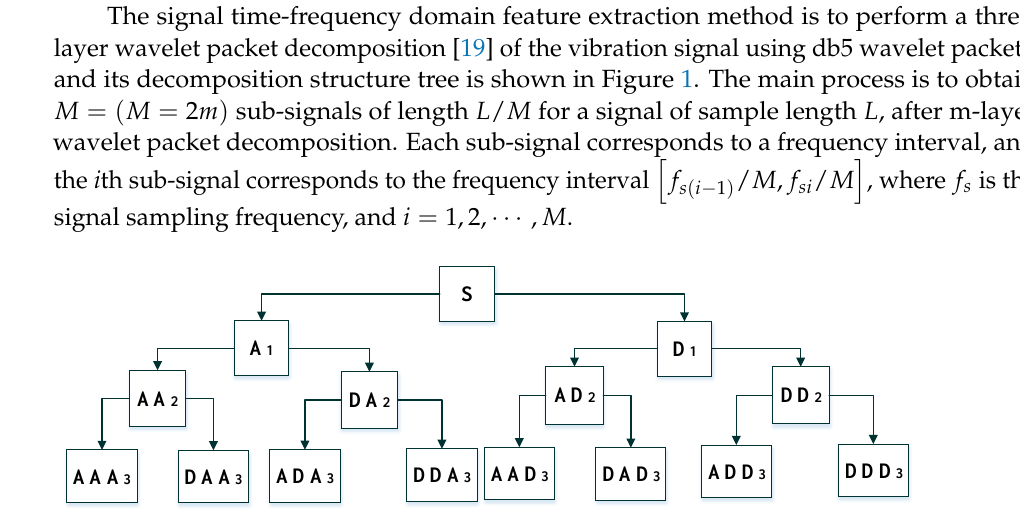
Figure 1. Wavelet packet signal decomposition structure diagram.